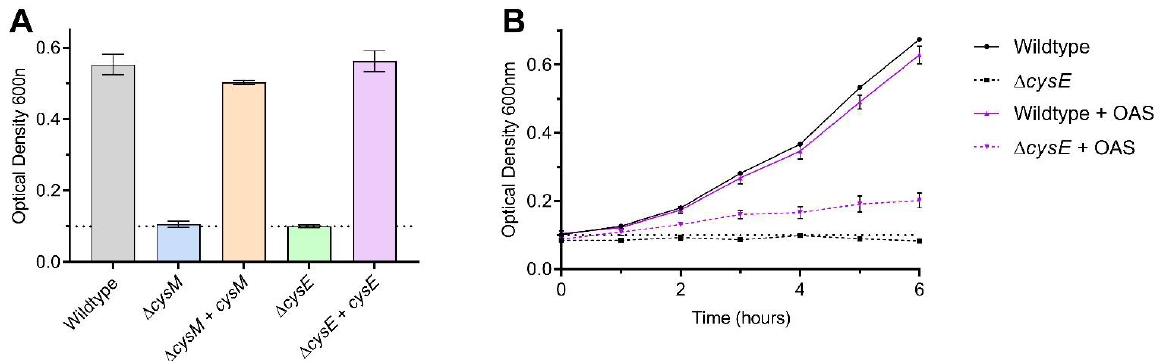
Figure 6. Growth of cysM and cysE mutants on sulfide. ( A ) Growth of wildtype, ∆ cysM , ∆ cysE and genetically complemented strains in defined media with sulfide as the sole sulfur source, displayed as the optical density reached after 6 h. ( B ) Chemical complementation of the OAS deficient cysE mutant strain in defined media with sulfide as the sole sulfur source, by the exogenous addition of OAS. The inoculum level is indicated by the dashed lines.